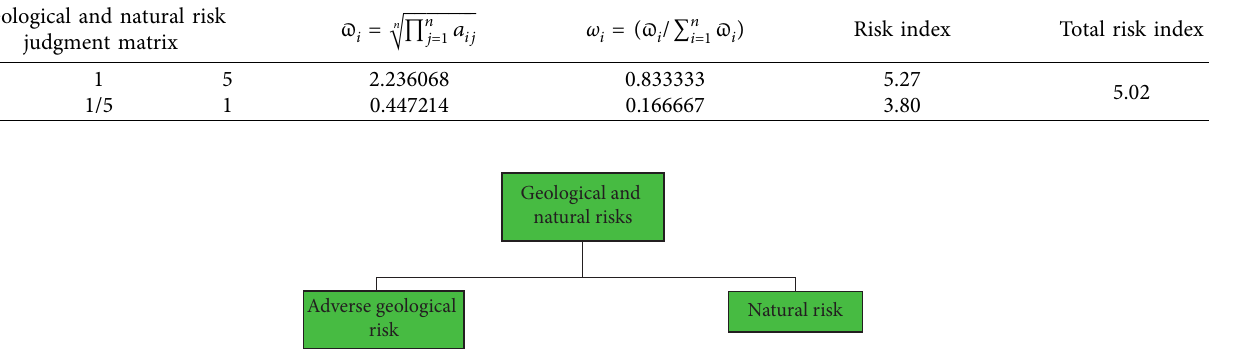
Figure 9: Geological and natural risk hierarchy. Table 45: Taishan road station total risk judgment matrix.